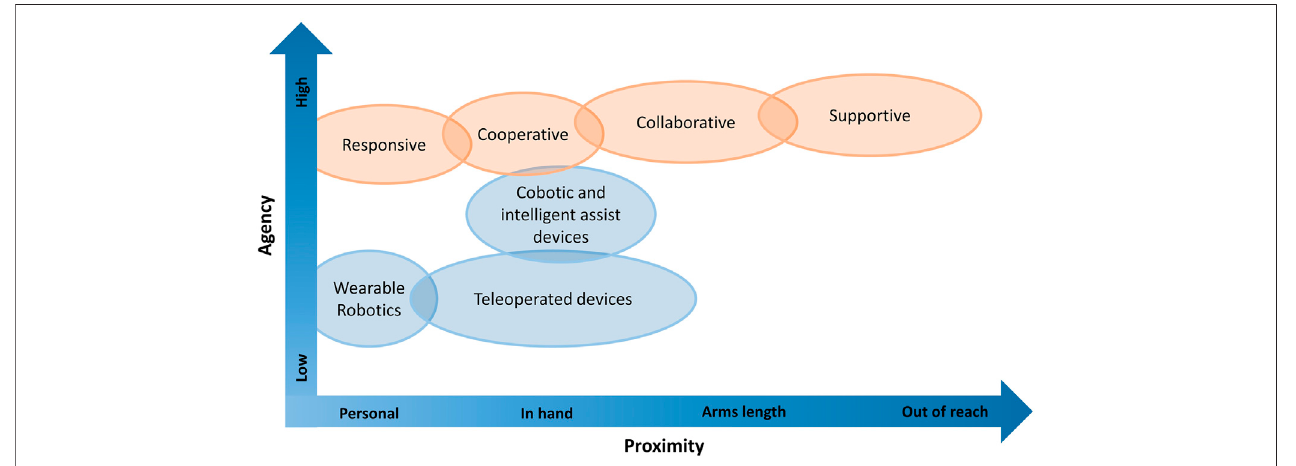
FIGURE 7 | Classi fi cation scheme for HRI, by proximity of interaction and autonomy of the robot. Adapted from Haddadin and Croft